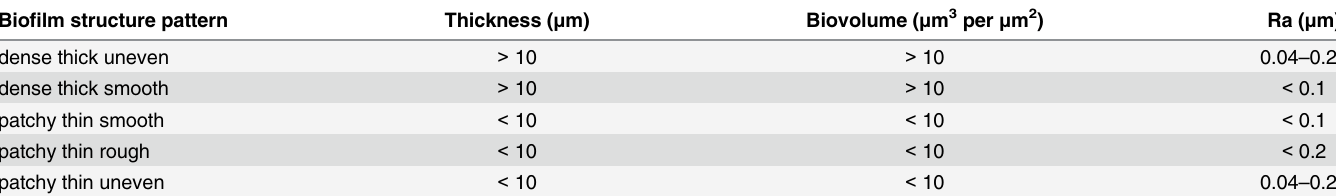
Table 2. Definitions of the biofilm structure patterns described in this